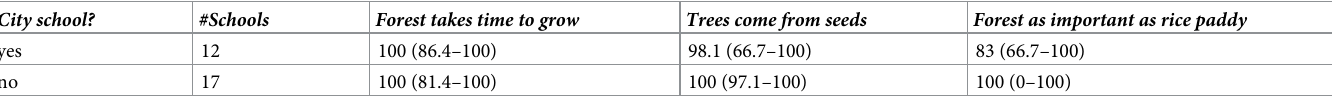
Table 3. Responses from students when schools are classified by location.